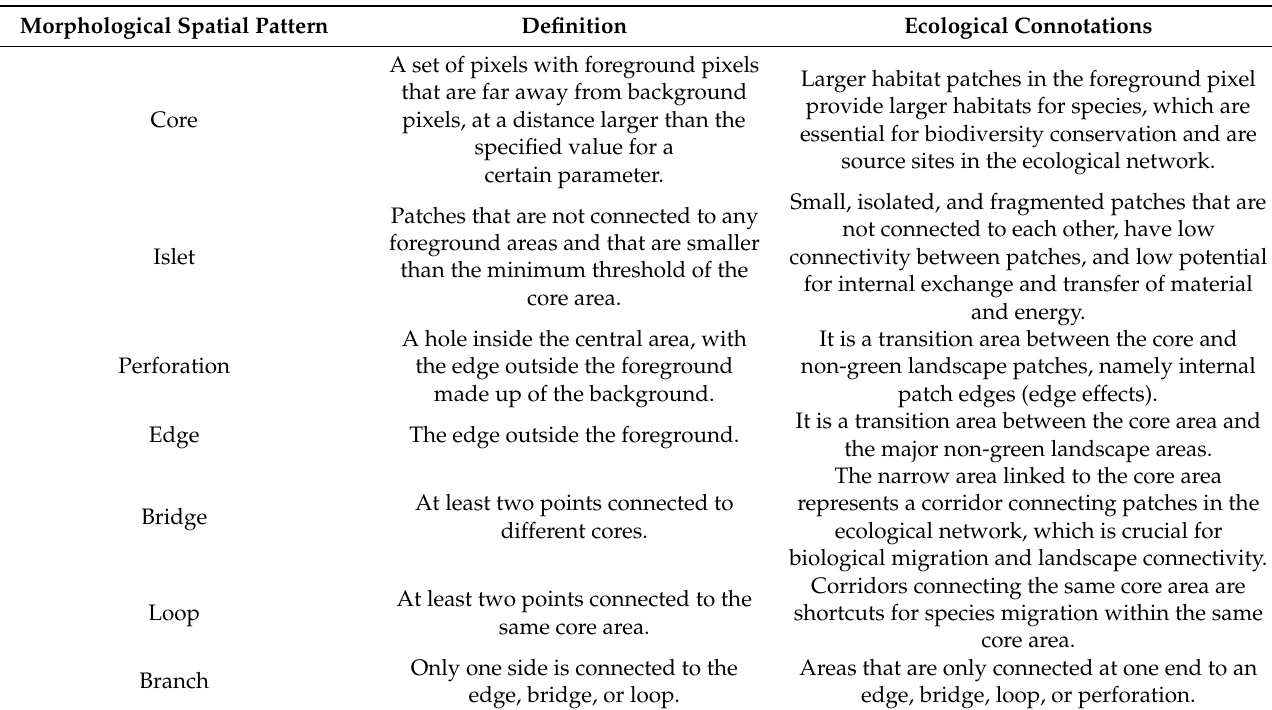
Table 3. Classes of morphological spatial patterns and their ecological